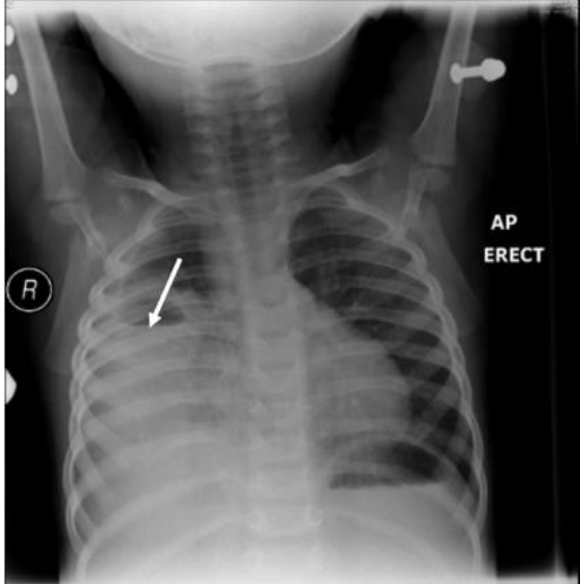
Figure 5. Large homogenous added density occupying most of the right side of the hemithorax with a large amount of air fluid in the superior aspect, as shown by the white arrow, silhouetting the cardiac border, costo- and cardiophrenic angles with no air bronchogram, suggesting large right-sided lung abscess with secondary mild hyperinflation on the left side of the lung.